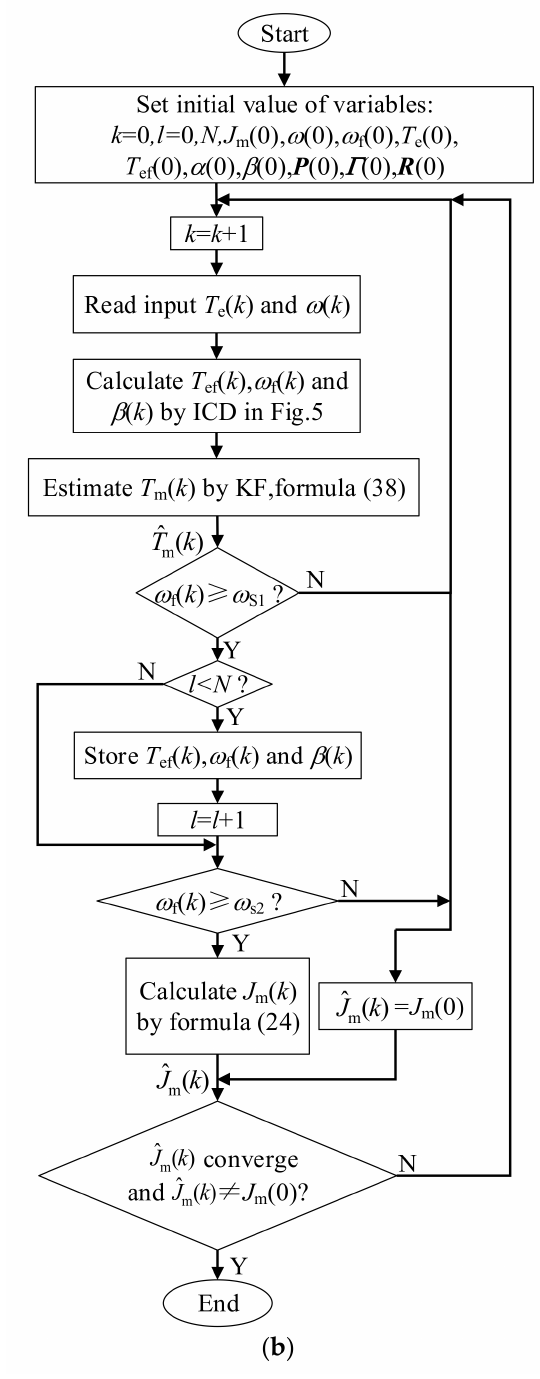
Figure 3. Principle of method: ( a ) Experimental process of moment of inertia identification; ( b ) Identification flow